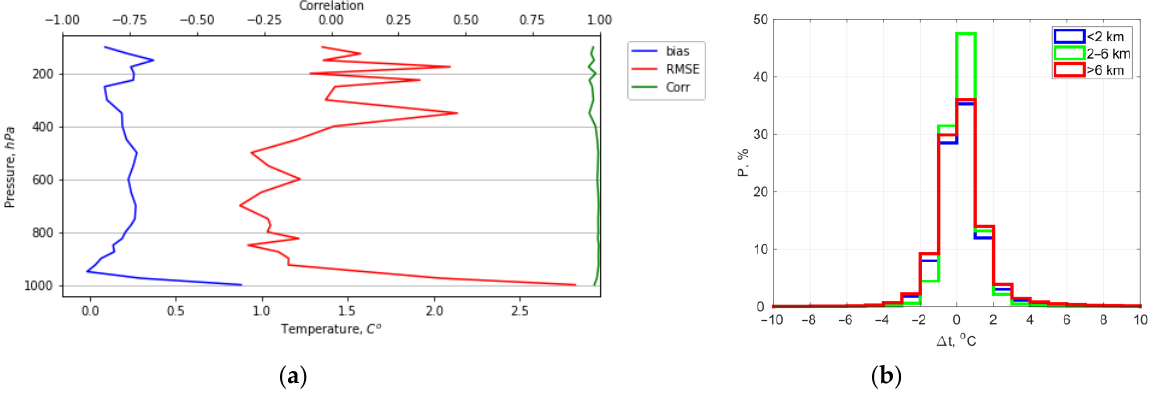
viations Δ f ( b ) for the coordinates of the specified aerological stations.